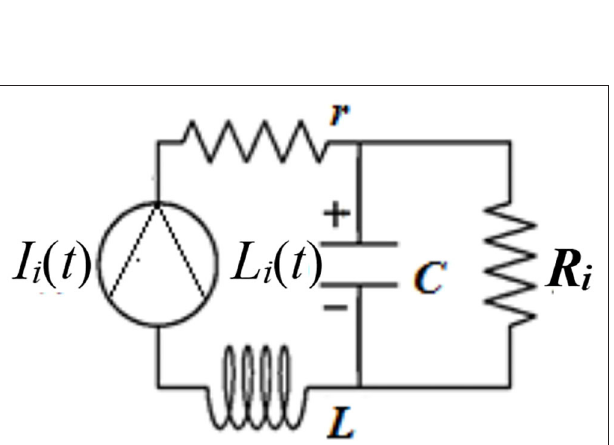
FIGURE 4 | WK-4S analog circuit